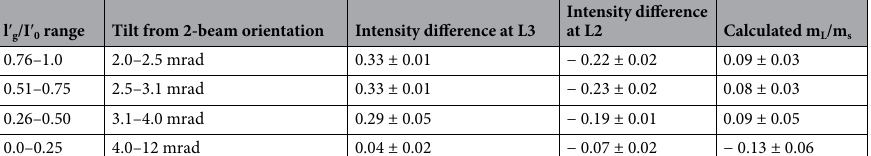
Figure 6. The difference (Δ) signal at L 3 and L 2 energy loss edges of Fe plotted against the I scatter plots are the experimental values whereas the solid curves are the running average of the experimental data over an interval of 0.05. The inset shows the simulated magnetic signal in the same tilt range as for the experimental data. The axes labels for the inset figure are same as the main figure, with the difference that the values in the experimental plot are normalized to the maximum L 3 edge intensities in the originally acquired EELS spectra (described in “Methods” section).